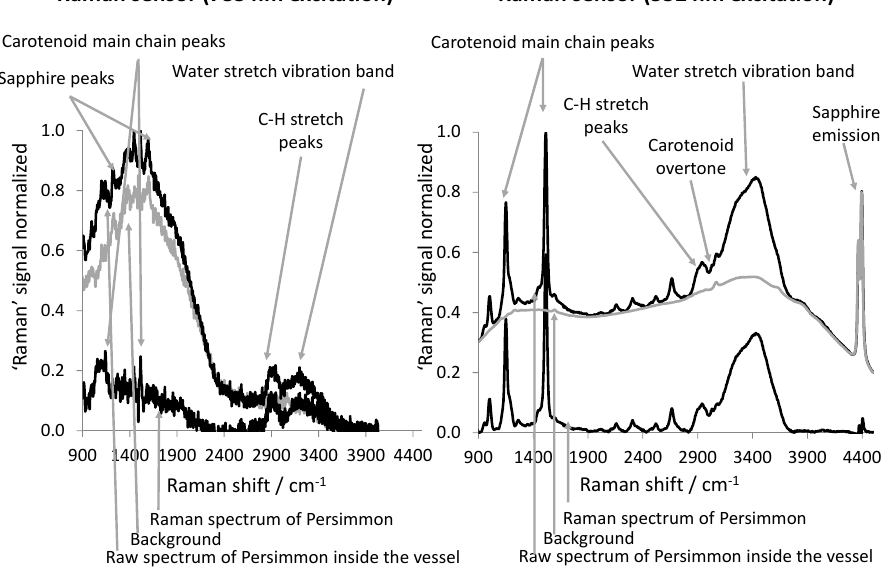
Figure 2. ( left ) Raw (black) spectrum and purified (black baseline) Raman spectrum from a piece of persimmon fruit inside the vessel acquired with the 785 nm excitation Raman sensor. ( right ) Raw (black) spectrum and purified (black baseline) Raman spectrum from a piece of persimmon fruit inside the vessel acquired with the 532 nm excitation Raman sensor.